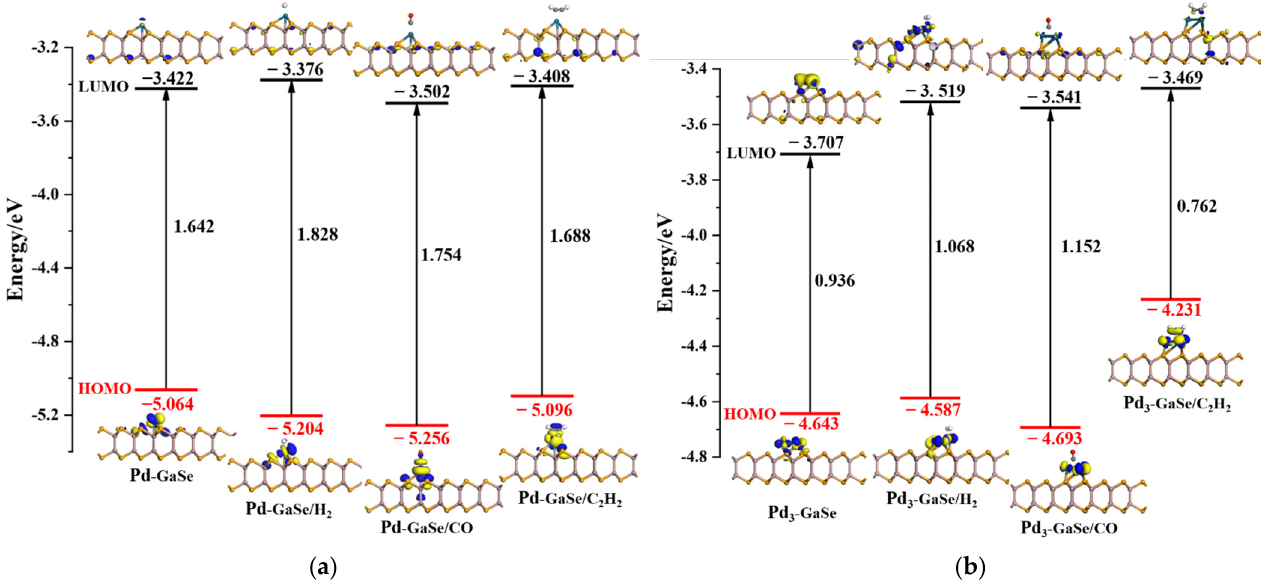
Figure 13. HOMO and LUMO distributions of ( a ) Pd-GaSe adsorption system and ( b ) Pd 3 -GaSe adsorption system.